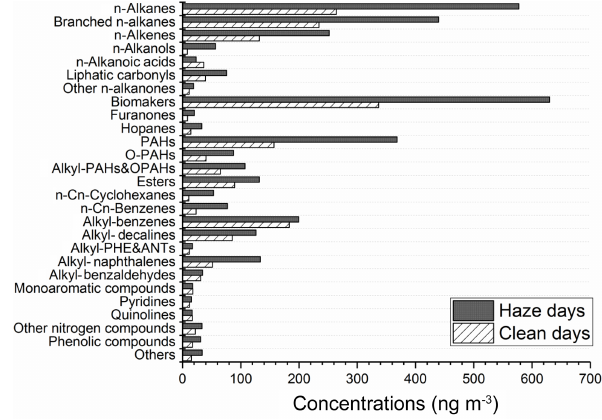
Figure 2. A comparison of organic compound groups between non- haze and haze days. The average total concentration of the identified group was calculated in the non-haze (13d) and haze periods